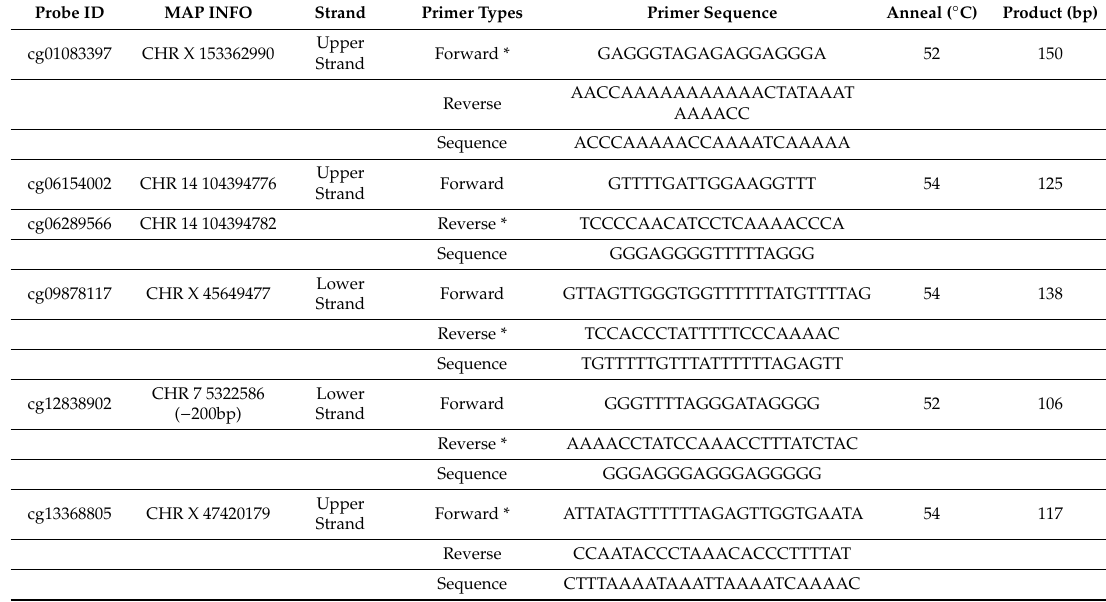
Table 3. Primers for